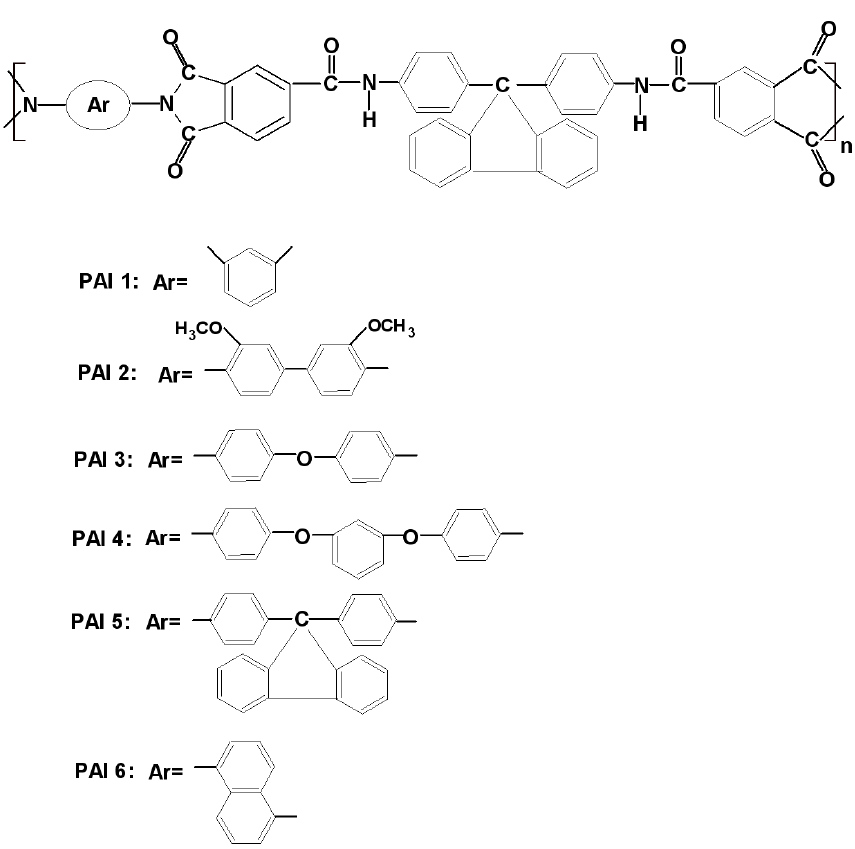
Fig. 2 Chemical structure of the synthesized